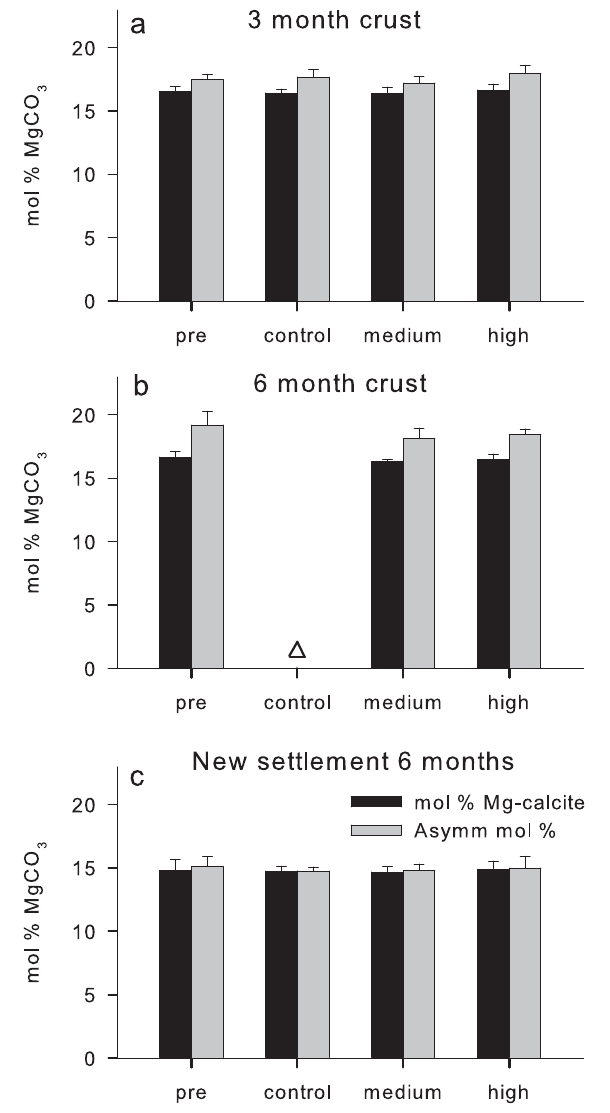
Figure 2. Magnesium composition for experimental growth of P. onkodes . Mol% is for Mg-calcite mol% MgCO 3 . Asymm mol%